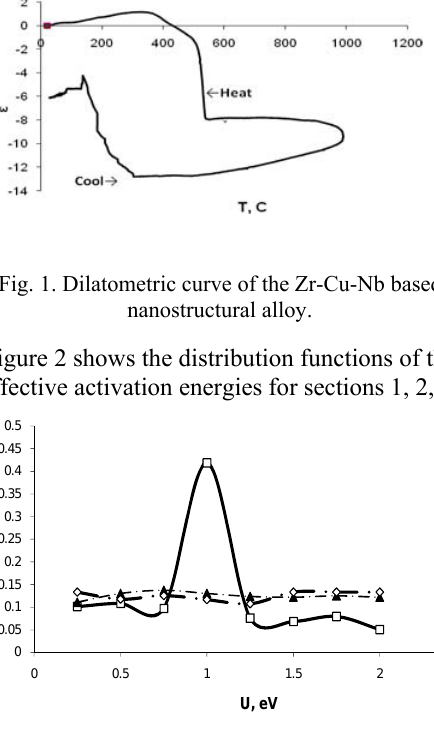
Fig. 2. Distribution functions of the effective activation energies for sections 1, 2, 3. ( □ -1, ▲ -2, ◊ -3)